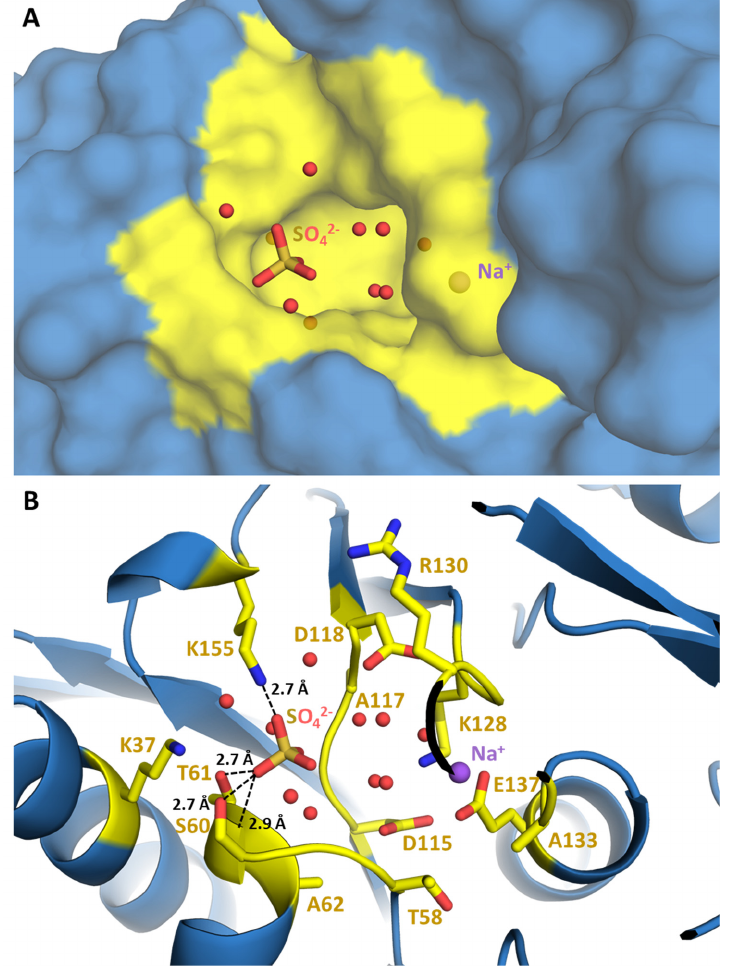
Figure 4. CrRPI1 catalytic pocket. ( A ) The Connolly solvent exclusion surface of the catalytic cleft of CrRPI1 with ligands in it (sulfate ion, water, sodium ion). Residues contributing to the cavity are colored in yellow, other residues are colored in blue. ( B ) The same view of the catalytic cleft as in ( A ). The protein is colored in blue and represented in cartoon. Residues contributing to the catalytic cleft are colored in yellow and their side chains are represented in sticks. Polar contacts between ligand and residues are represented in black dashed lines with corresponding interatomic distances indicated in Ångströms